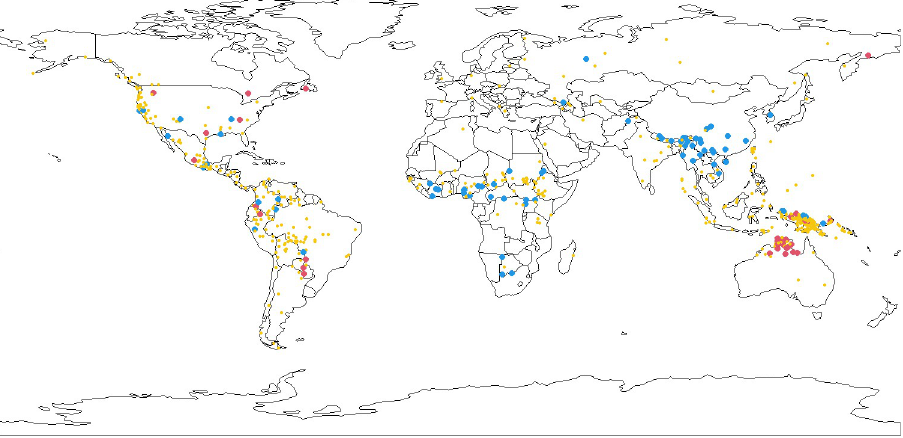
Fig 2. Large (red dots), small (blue dots), and intermediate (yellow dots) values of mean word length of WALS genera. Country borders were generated using [27].